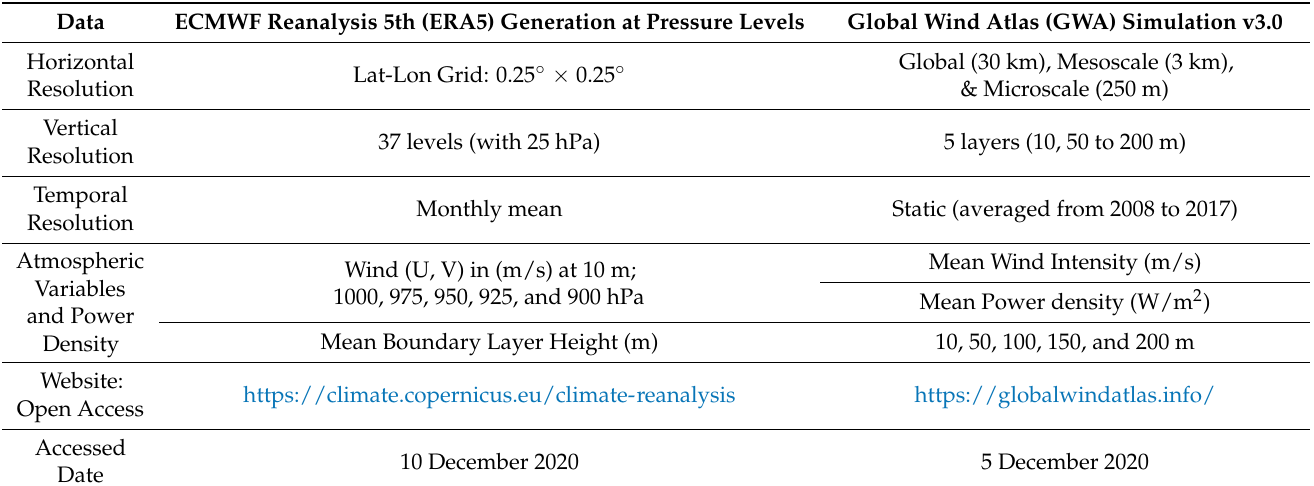
Table 1. Description of experimental data in the present